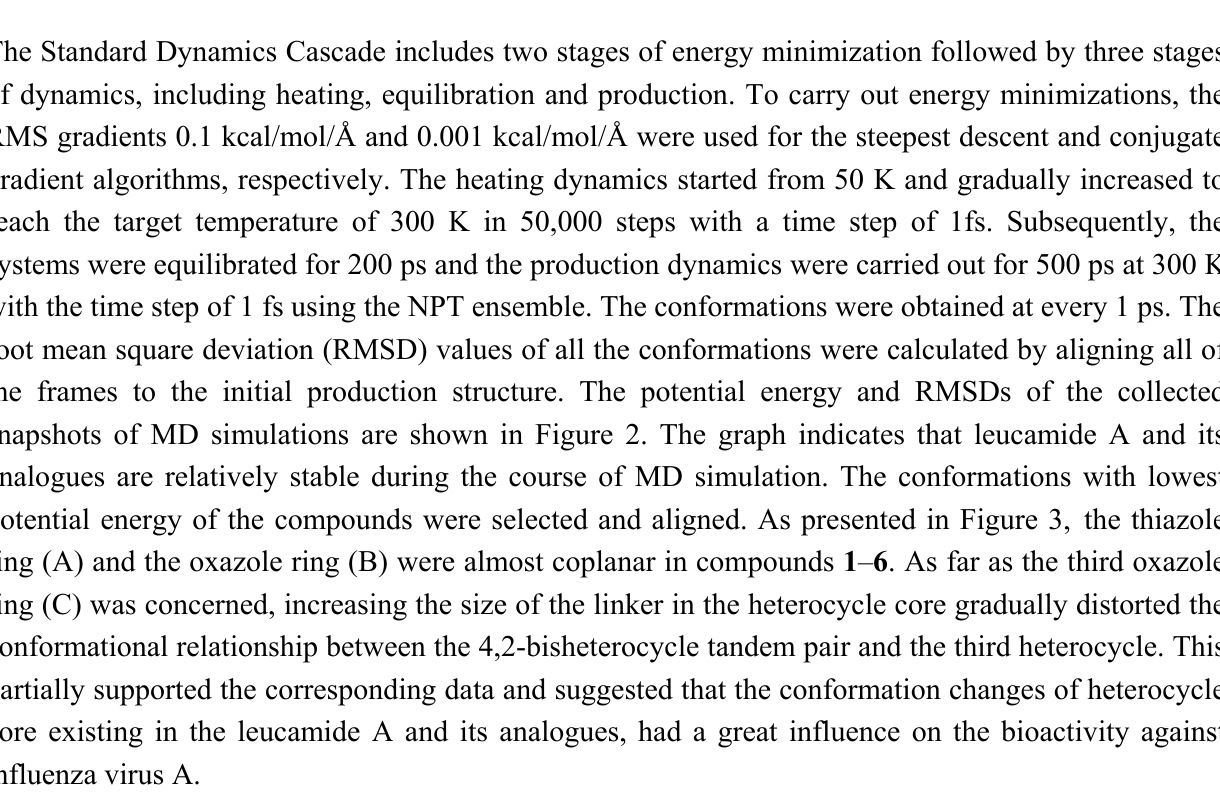
Figure 2. Potential energy and RMSDs profiles of compound 1 – 6 during MD